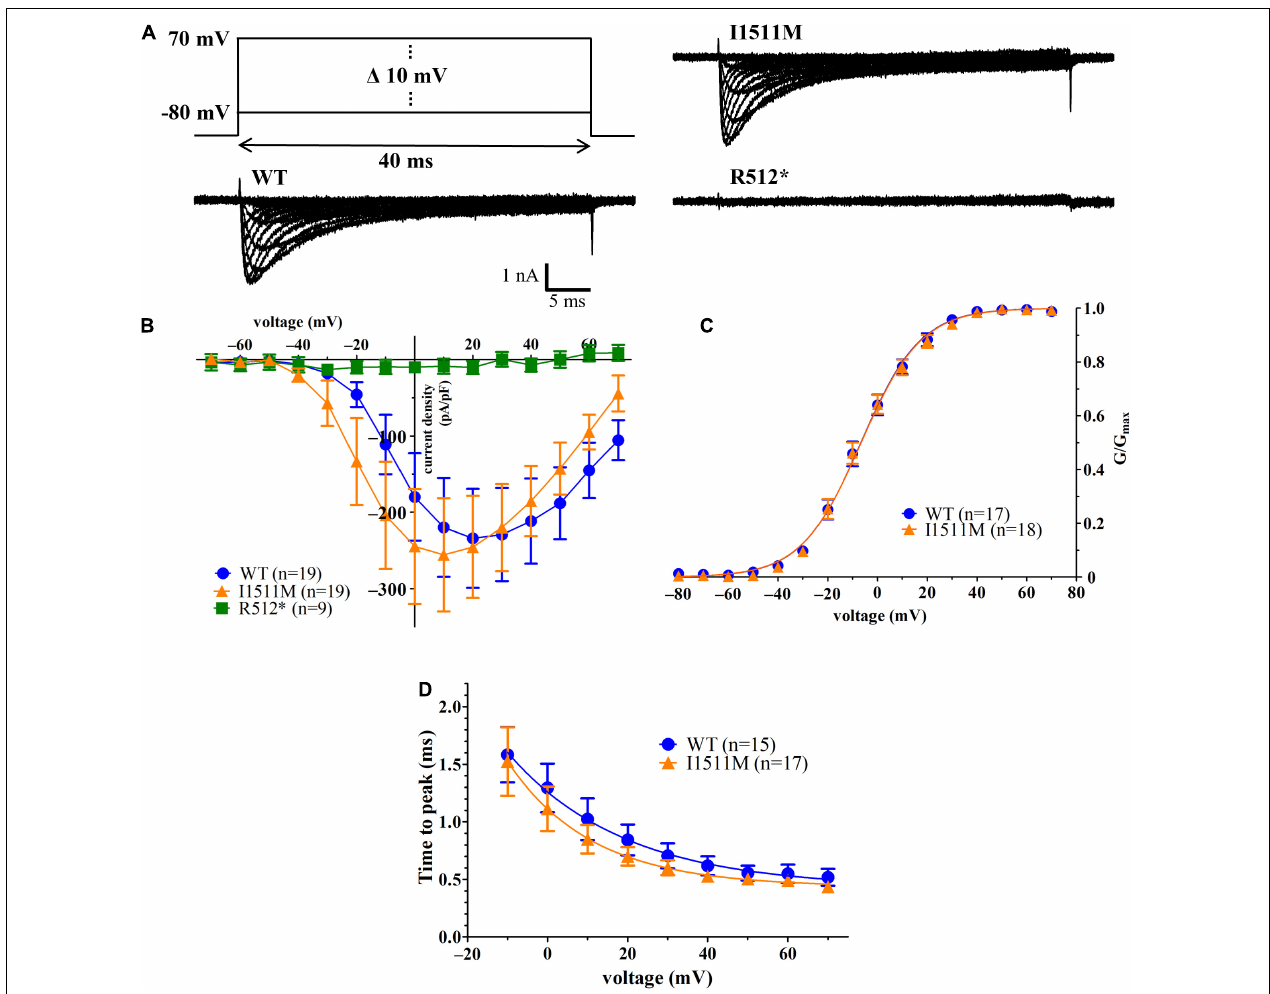
FIGURE 3 | Electrophysiological identification of R512* as a loss-of-function mutation, while I1511M mutated channels produce robust sodium channel activation comparable to WT channels. (A) Representative current traces for cells transfected with hNa v 1.8 WT (left trace), I1511M (upper right trace) or R512* (lower right trace). The voltage protocol is shown above the WT trace. (B) Current-voltage relationship of hNa v 1.8 WT, I1511M and R512*. (C) Conductance-voltage relationship of sodium channel activation of hNa v 1.8 WT and I1511M. (D) Development of time to peak values of hNa v 1.8 WT and I1511M over the different voltages. Both data sets were fitted with an exponential decay